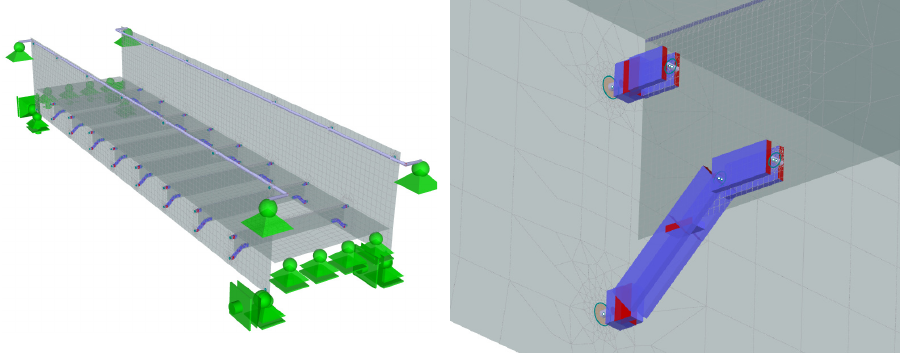
Figure 5: Finite element model of glass bridge. Figure 6: Connection between cross beam and